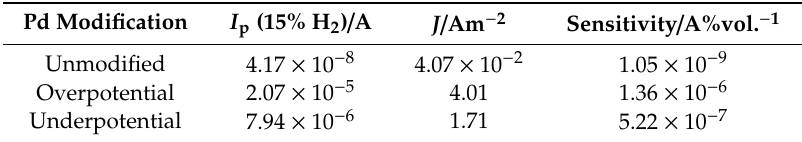
Table 4. Analytical parameters obtained for H 2 oxidation in [C 4 mim] [NTf 2 ]: oxidation peak